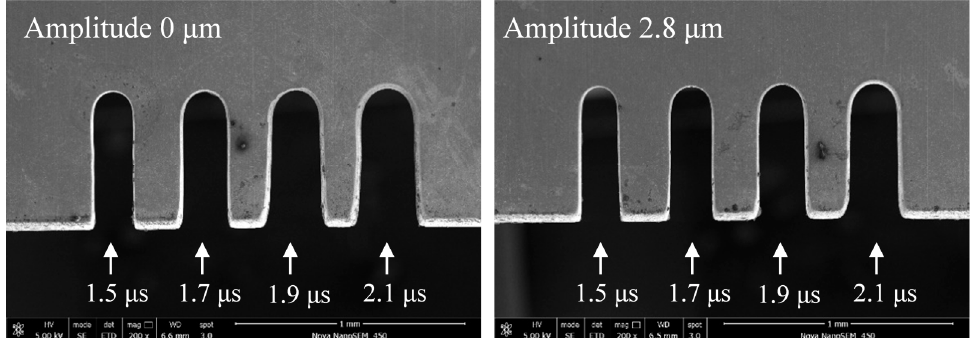
Figure 18. Microslits under different pulse widths.